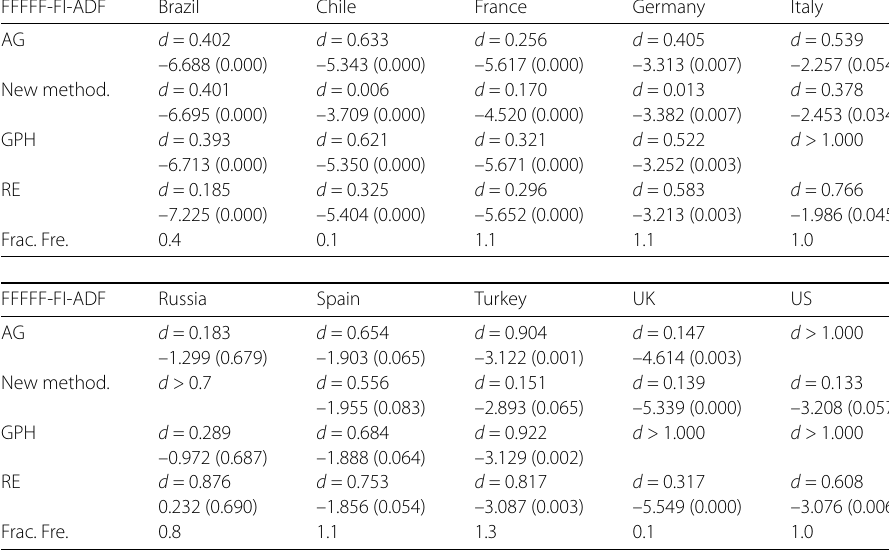
Table 4 The results of the FFFFF-FI-ADF